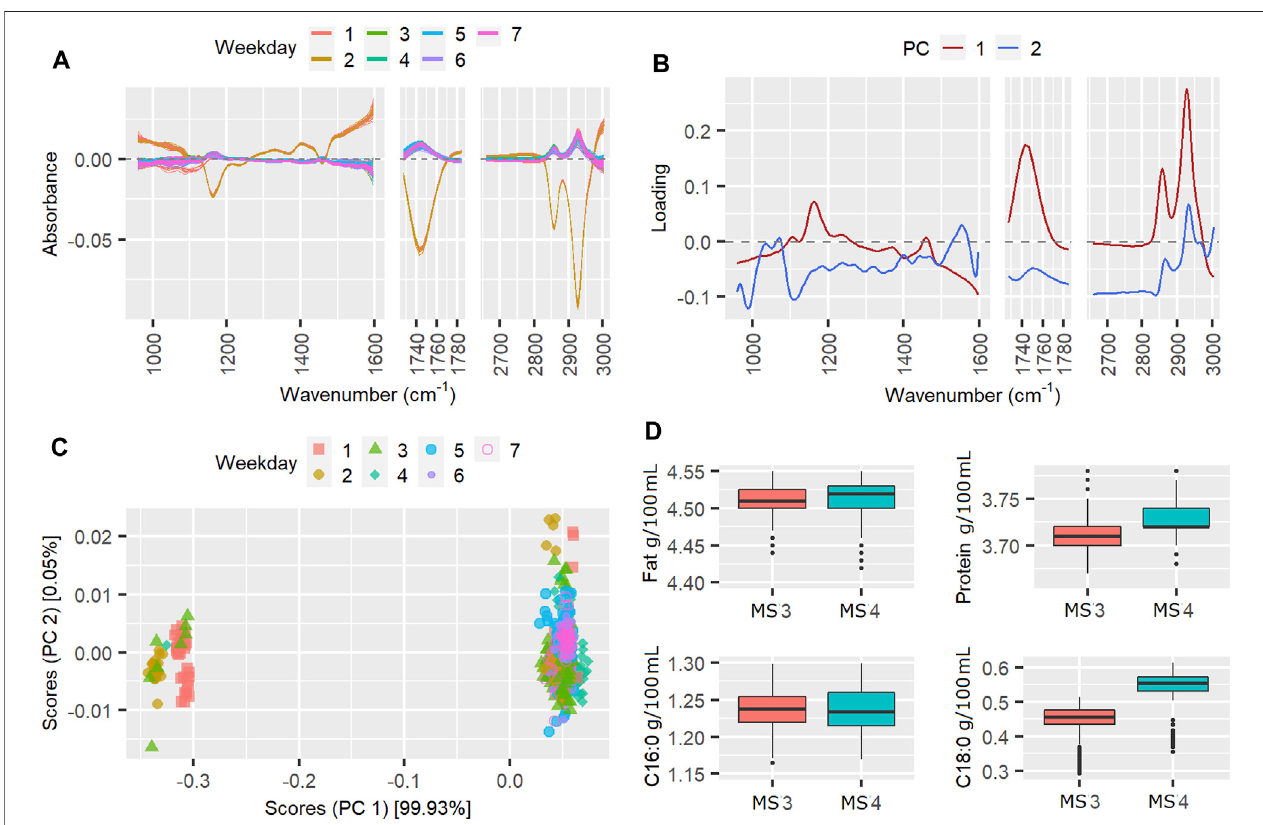
FIGURE 4 | Mean cenered spectra (A) , instrument loading plots (B) and scores (C) for pilot spectra from week 86, in which the TSSQ (adj) exceeded 3 standard deviations. Boxplots (D) show the predicted fat, protein, C16:0 and C18:0 values from each instrument and their mean values and standard deviations (SDs), marked * for 1SD, ** for 2SDs and *** for 3SDs greater than the SD of the 177 weeks TSSQ (adj) values.